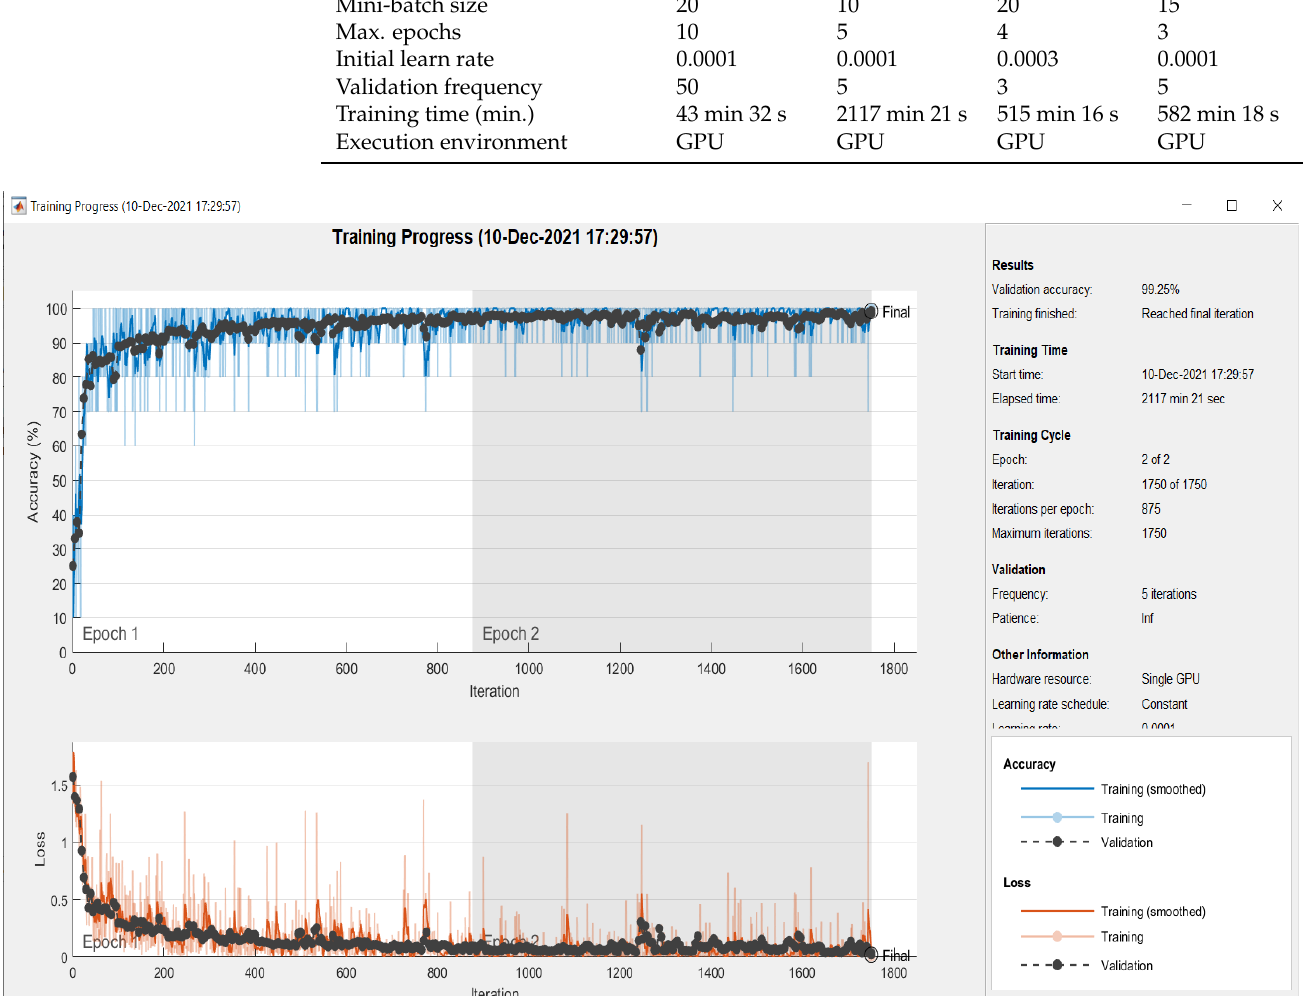
Figure 14. Display of the training process for the dataset using the ResNet-50 model.